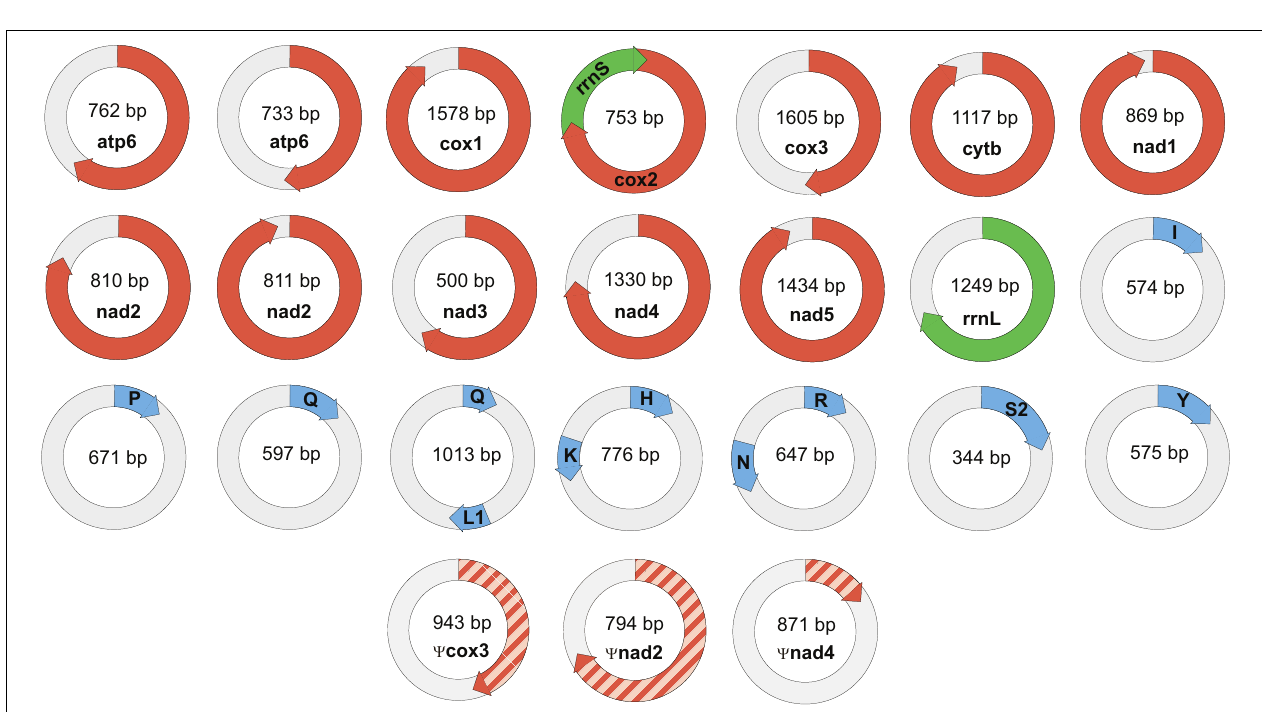
FIGURE 5 | Motifs specific to Dicyema sp. circular contigs. (A) Signal found in the majority of contigs. (B–E) Highly conserved signals found in a group of circular contigs of high length and coverage; (B) found in 541 contigs; (C) found in 284 contigs; (D) found in 234 contigs; (E) found in 438 contigs. All counts are provided at a p -value < 10 − 4 .